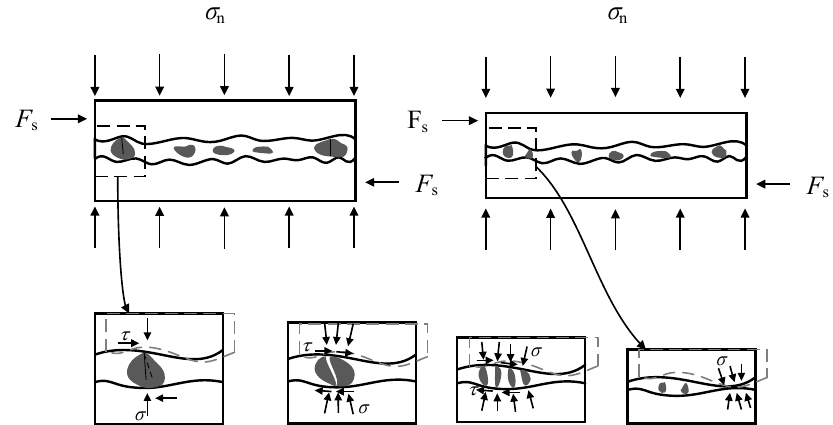
Figure 18. Failure mechanism of mortar joint before peak load (stages I and II).